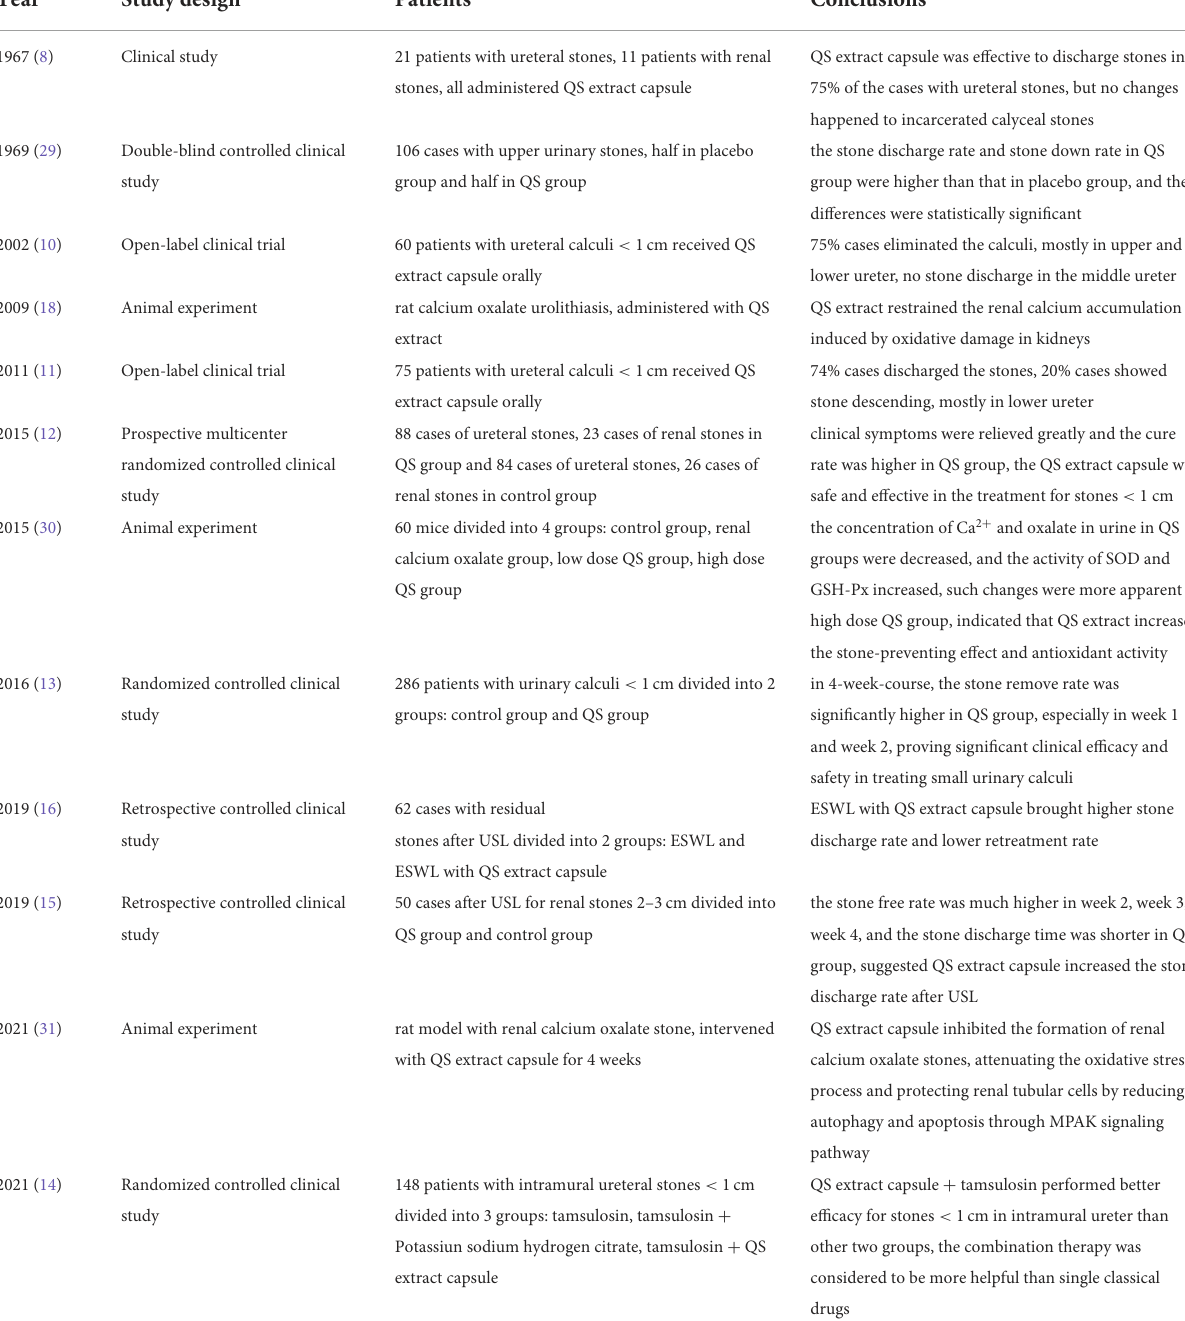
TABLE 2 Results of major research concerning the efficacy of urocalun for urinary